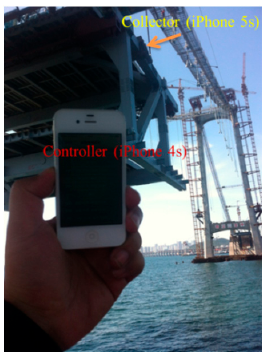
Figure 23. Position of collector and controller.